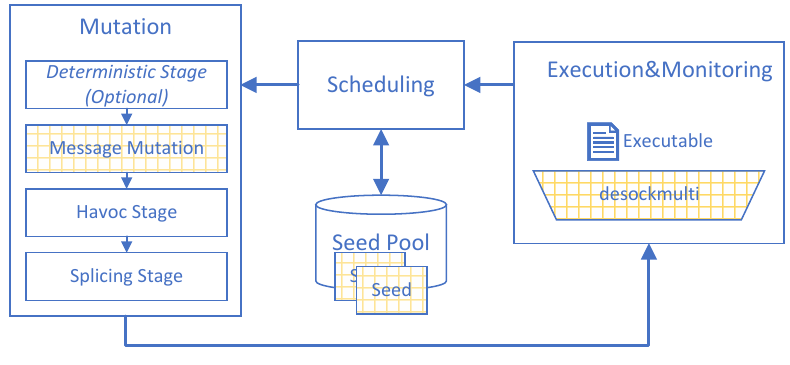
Figure 2. The architecture of MultiFuzz. It has the same architecture as other coverage-based fuzzers like AFL [3], with the changes highlighted by yellow